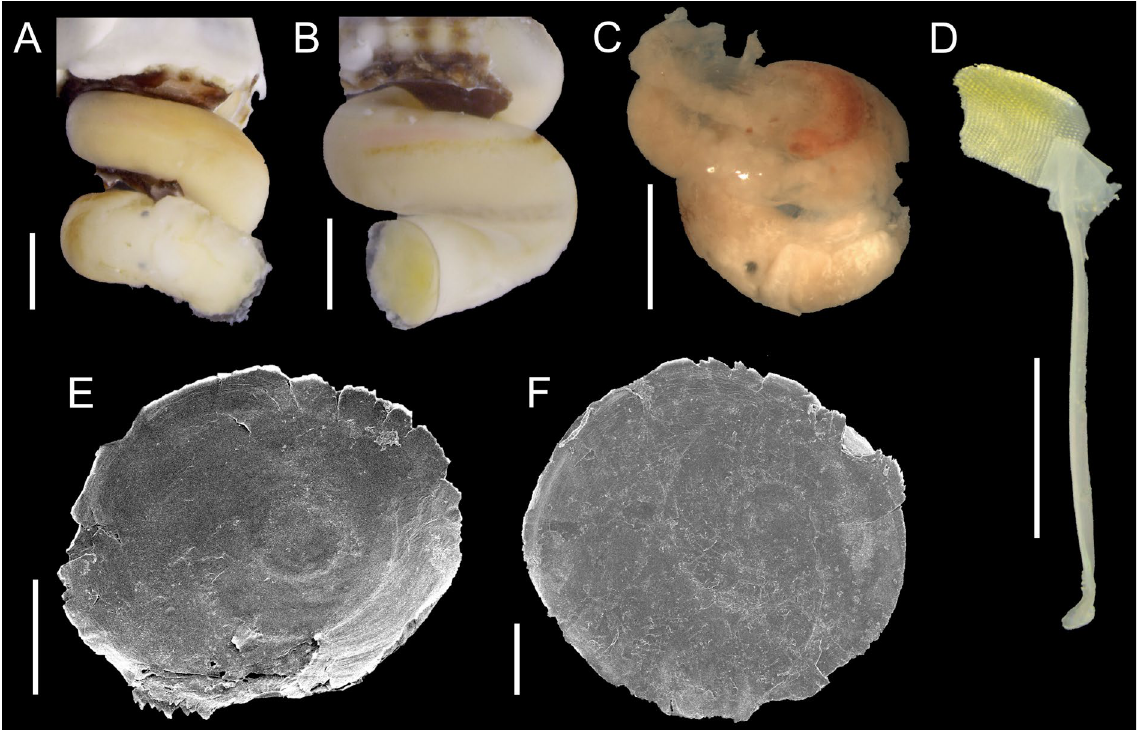
Fig. 14. Monophorus olivaceus (Dall, 1889). A–C, E–F . MNRJ 34615. D . MNRJ 34028. A–C . External morphology. D . Jaw (gold) and radula (white). E–F . Operculum. Scale bars: A–C = 1 mm; D = 500 µm; E–F = 250